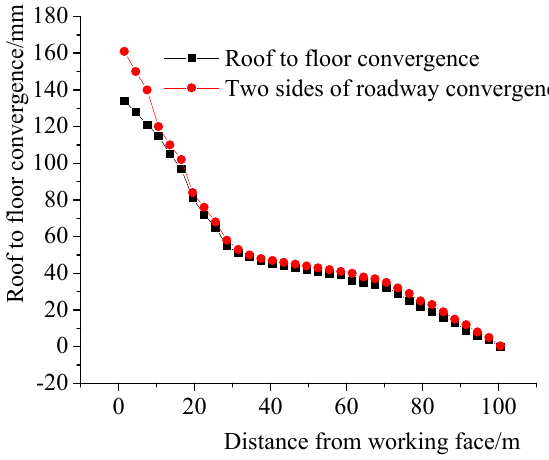
Figure 18. Displacement change curves of the roadway.